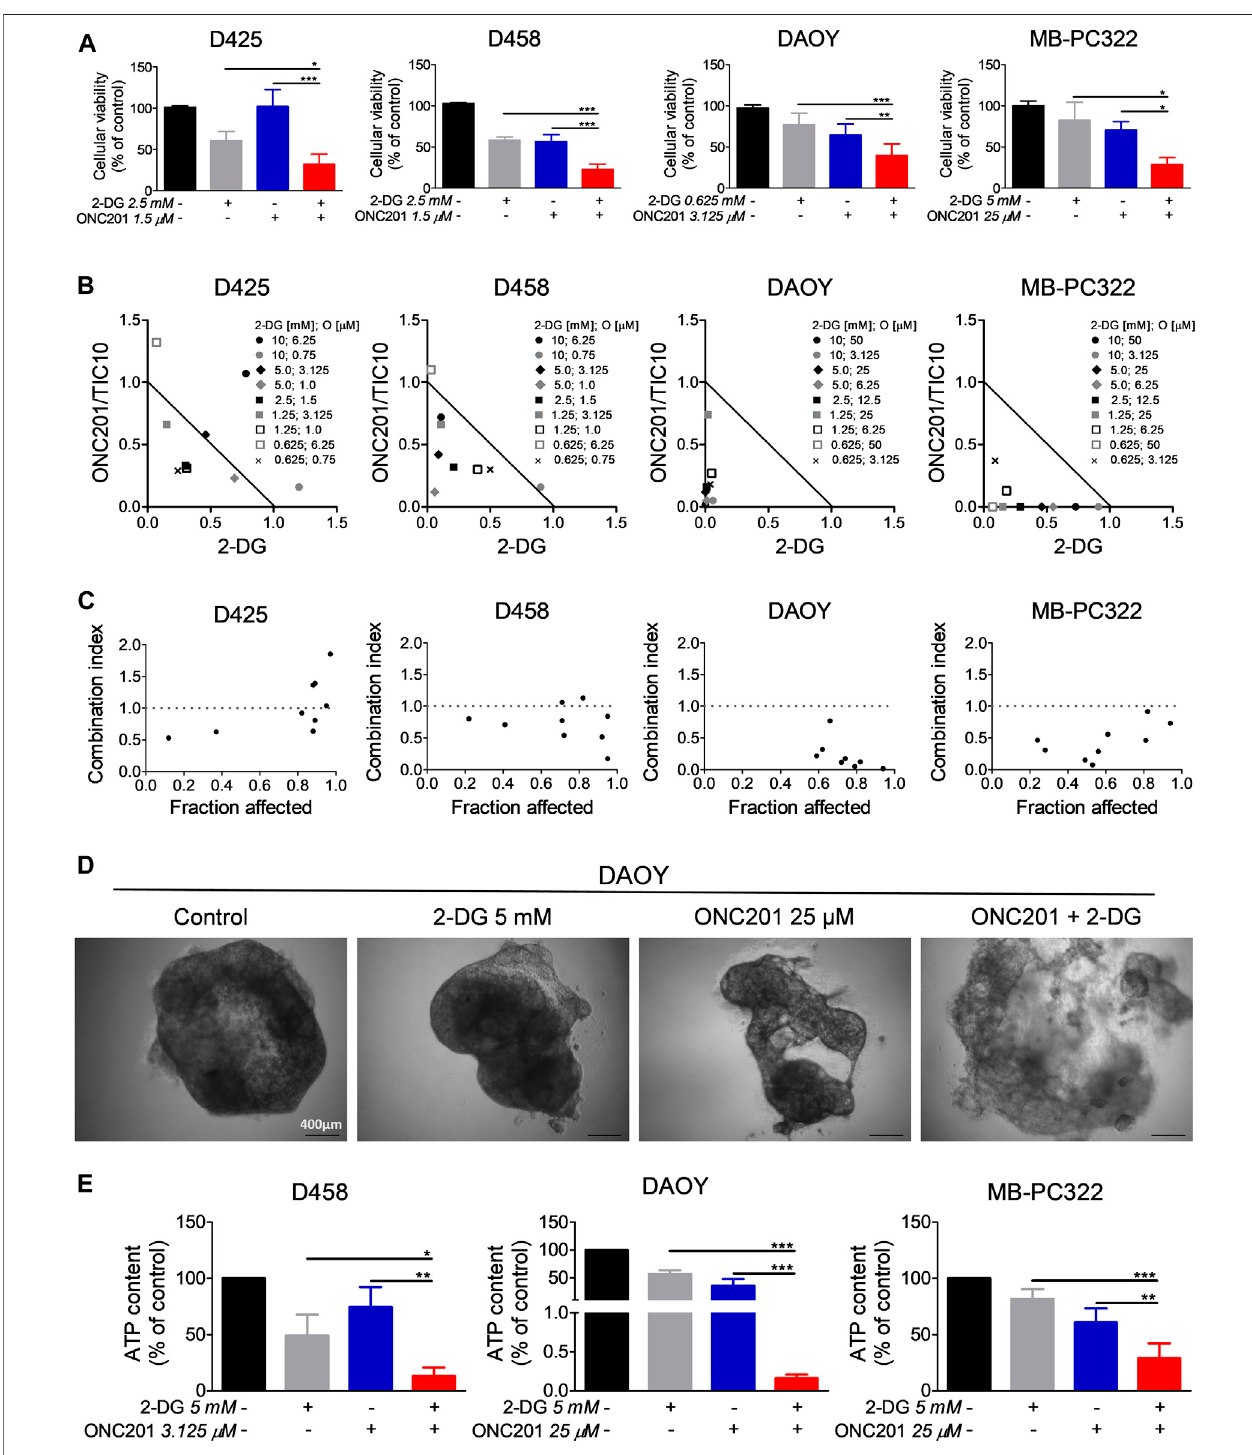
FIGURE 5 | 2-Deoxyglucose and ONC201/TC10 synergistically inhibit the cellular viability and the growth of spheroids in medulloblastoma. (A) , D425, D458, DAOY and MB- PC322 cells were treated with solvent or indicated concentrations of 2-Deoxyglucose and/or ONC201/TIC10 under serum starvation (1.5%FBS) for 72 h prior to performing MTT assays.Columns:mean.Errorbars:SD. N (cid:1) 3.* p < 0.05,** p < 0.01,*** p < 0.005. (B) ,D425,D458,DAOYandMB-PC322cellsweretreatedfor72 hasindicated.MTTassayswere performed and normalized isobolograms were calculated. Data points within the triangle are indicative for a synergistic, data points outside of the triangle point towards an antagonisticanddatapointsonthediagonallineindicateanadditivedrug-druginteraction.Dataarerepresentativeforthreeindependentexperiments. (C) ,Combinationindex(CI)-plots formedulloblastomacellstreatedasdescribedforB.ACI < 1signi fi esasynergistic,aCI (cid:1) 1anadditiveandaCI > 1anantagonisticdrug-druginteraction. (D) ,Microphotographsof DAOY spheroids that were grown for 14 days. Treatment as indicated was performed on d 7, d 9, and d 12. Magni fi cation, × 4. (E) , D458, DAOY and MB-PC322 spheroids were treated as described for D. CellTiter-Glo ® assays were performed to determine the ATP content. Columns: mean. Error bars: SD. N (cid:1) 3. * p < 0.05, ** p < 0.01, *** p < 0.005.